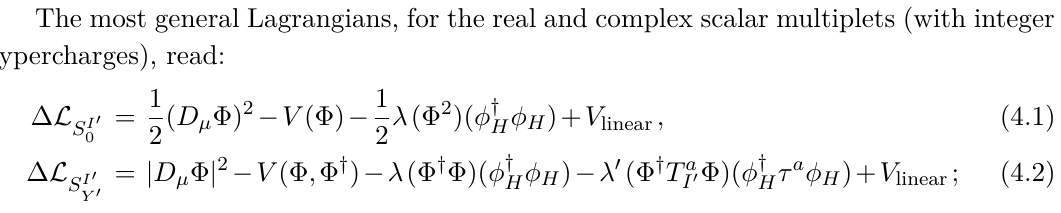
SM. The last column contains the scalar mediators that can have linear (renormalisable) couplings to the